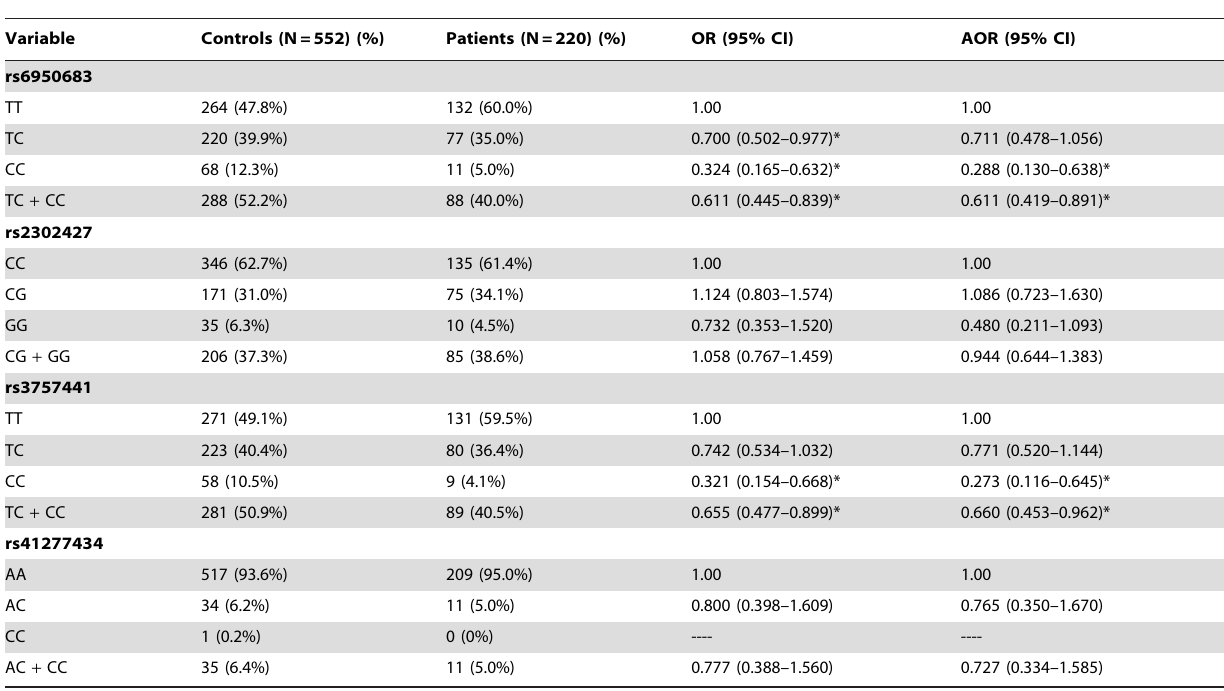
Table 2. Distribution of EZH2 genotypes in healthy controls and patients with HCC.